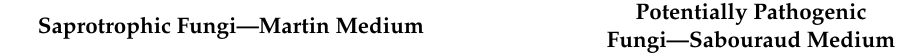
Table 6. Simpson species diversity coefficients for fungal communities in raw wastewater and at each wastewater treatment